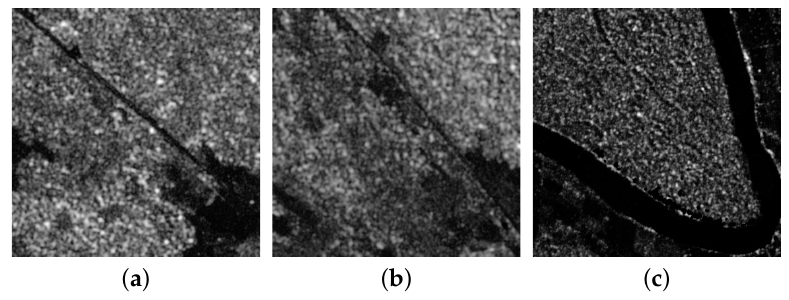
Figure 10. Restored real SAR images by the FTDE model: ( a ) The restored SAR1 image. ( b ) The restored SAR2 image. ( c ) The restored SAR3